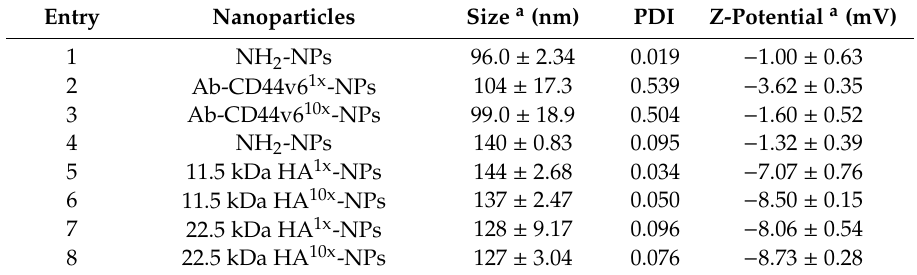
Table 1. Hydrodynamic diameter and Z potential values for the non-conjugated and conjugated nanoparticles.